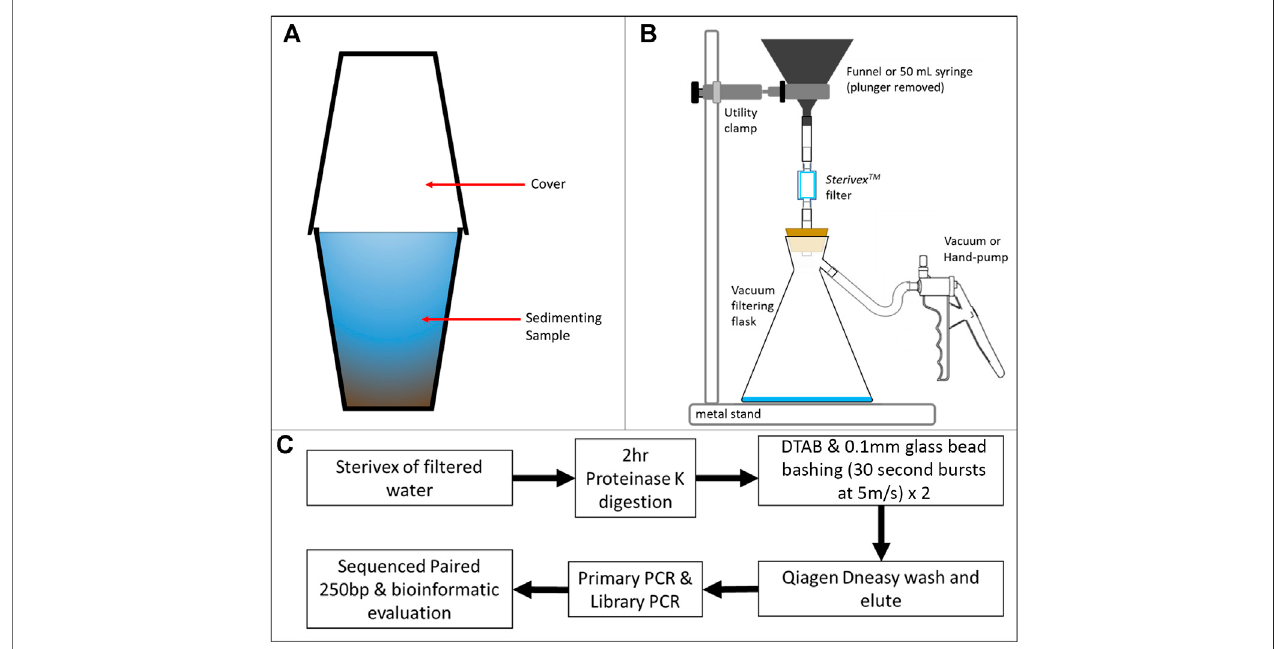
FIGURE 2 | eDNA-particulate fi ltration and eDNA extraction work fl ow. (A) Sedimentation of water samples in preparation for fi ltering (to minimise blockage of fi lters). (B) FiltrationofsamplestocollectandpreserveeDNAona0.22 μ m fi lter.Waterpassedthrougha Sterivex TM fi lter(0.22 μ maperture)fromeitherafunnelor50 ml sterile syringe with the plunger removed. The sample was drawn under powered vacuum or hand pump, depositing eDNA on the fi lter. (C) Work fl ow for sampling, DNA extraction, clean-up, PCR and library generation for sequencing and bioinformatic